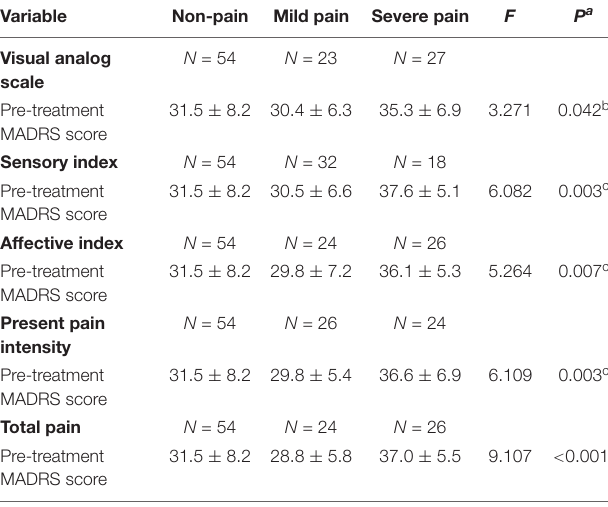
TABLE 3 | Results from mixed models for the moderating effects of pain symptom on changes in overall depressive symptoms from pre-treatment to post-infusion. Parameter